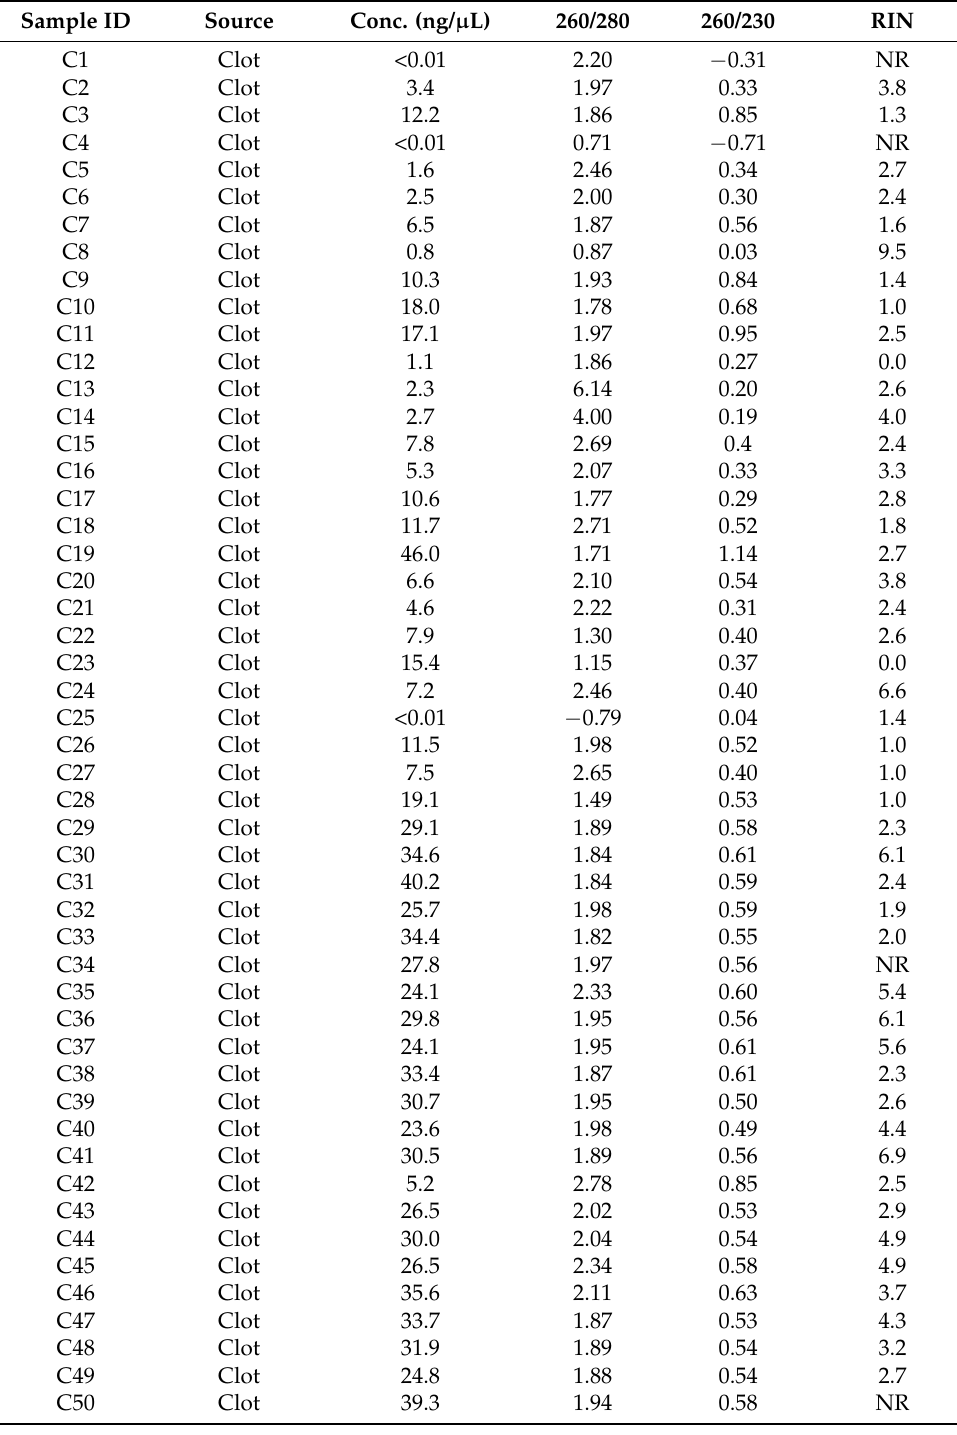
Table 2. RNA Quantity and Quality